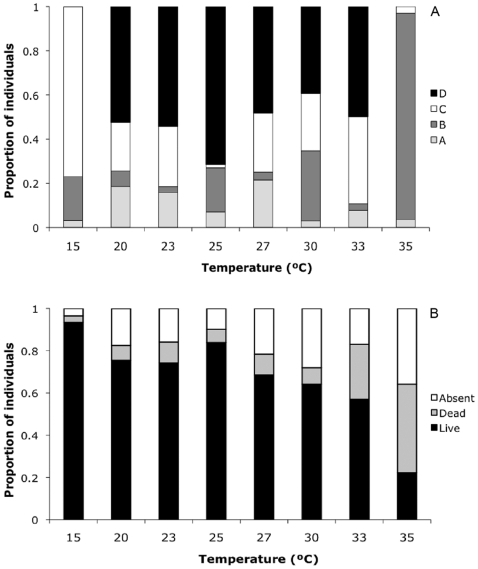

Hypothenemus hampei colonizing females, % in positions inside the berry (a); % mortality or failure to penetrate the coffee berry (b).